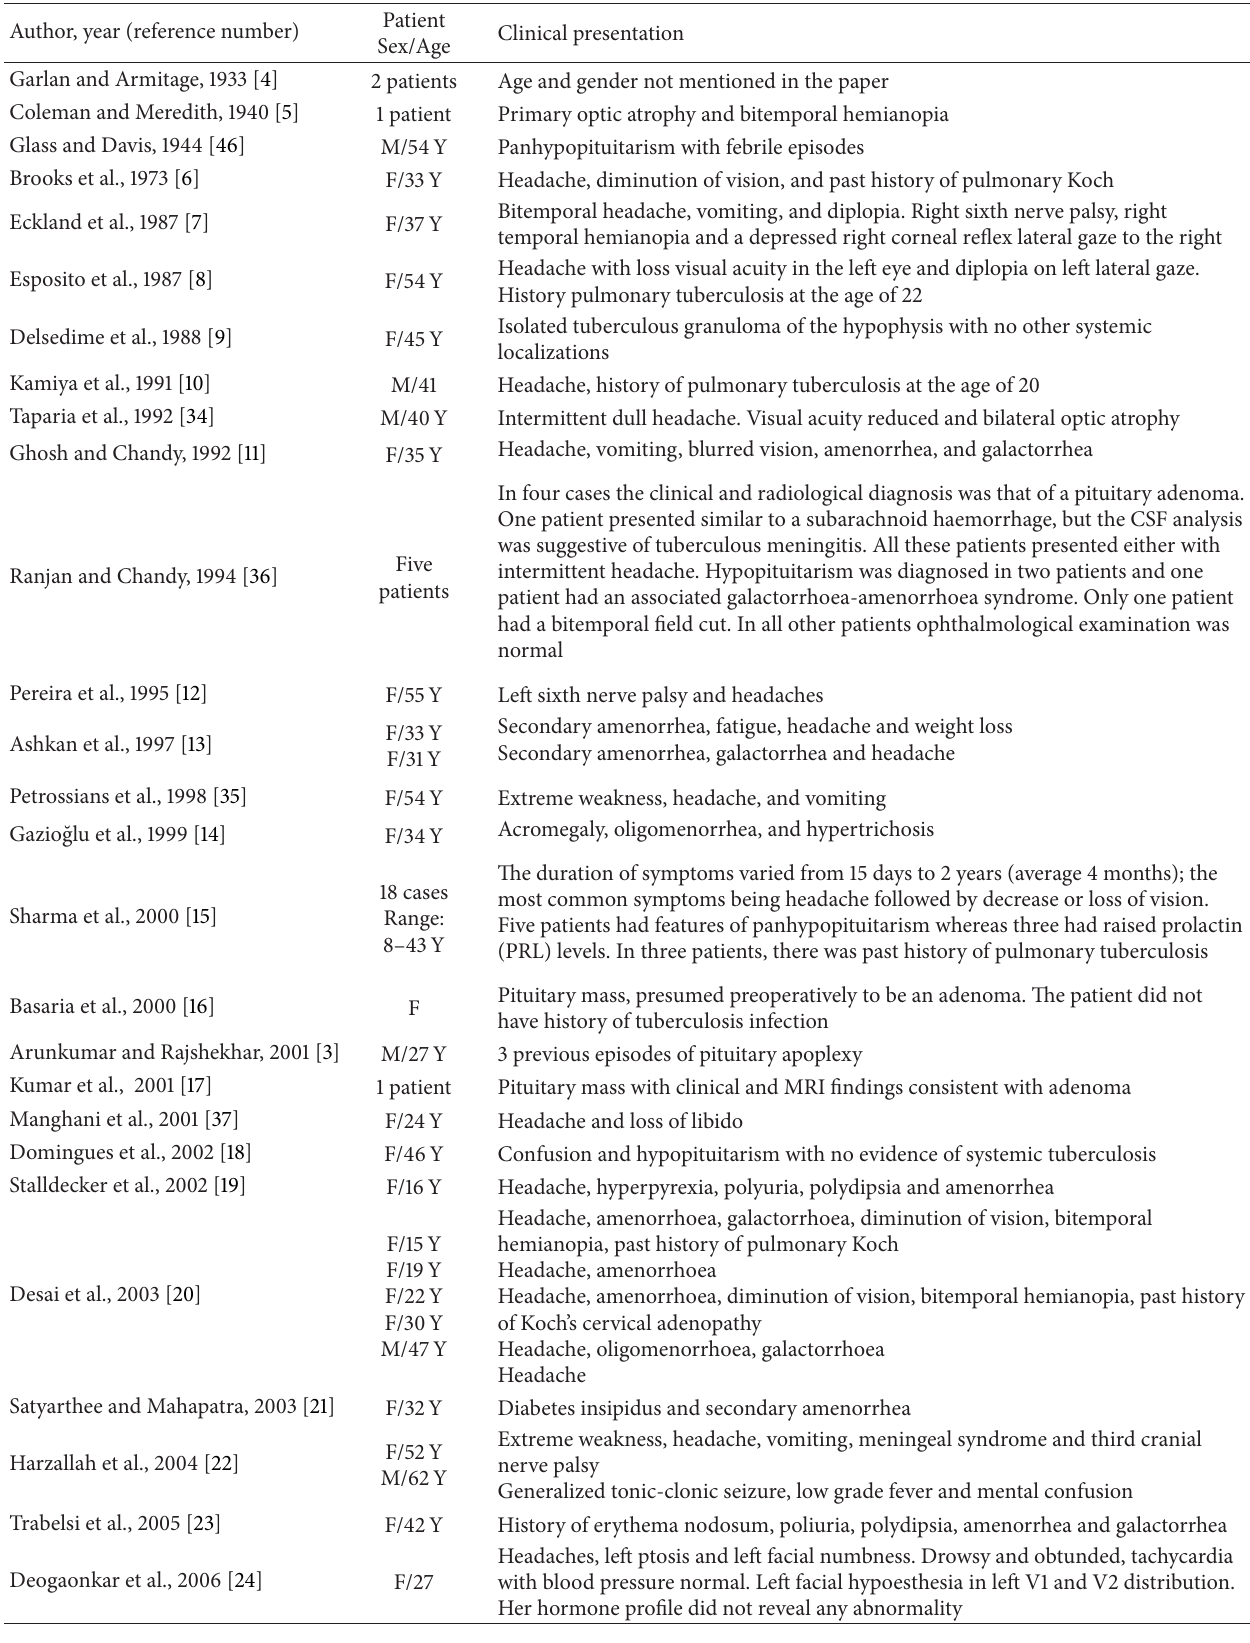
Table 1: Series previously